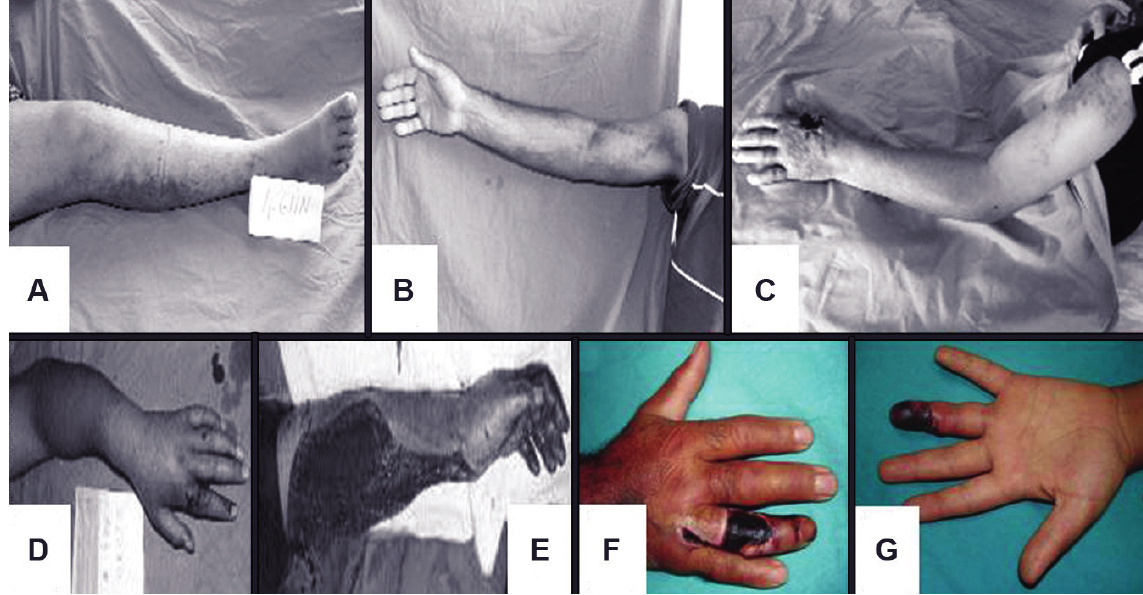
Figure 4. Common effects of snakebites in humans: ( A ) edema on the leg, ( B ) ecchymosis, ( C ) necrosis, ( D ) edema on the hand, ( E ) fasciotomy on the arm, ( F and G )